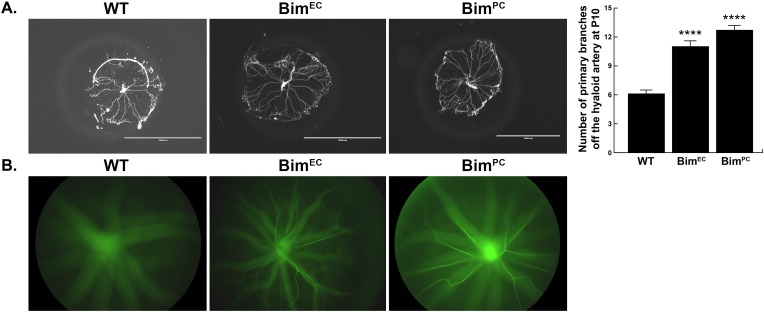
Hyaloid regression is regulated by Bim expression in vascular cells.Panel A demonstrates DAPI stained hyaloid vessel preparations from postnatal day 10 wild-type and conditional Bim knockout mice. Please note lack of Bim expression in EC or PC attenuated hyaloid vessel regression. (n =, ****P<0.0001) Scale bar equals 2000 μm. In Panel B, a representative image is shown of hyaloid vessels from 10 week old mice imaged using a Micron III indirect camera. Fundus images were taken prior to an intraperitoneal injection of 50 μl sodium fluorescein. While the retina was in focus on the Micron III, images were taken as the hyaloid vessels filled with fluorescein. These studies were performed by imaging hyaloid vessels from 5 mice (n = 5) with similar results.